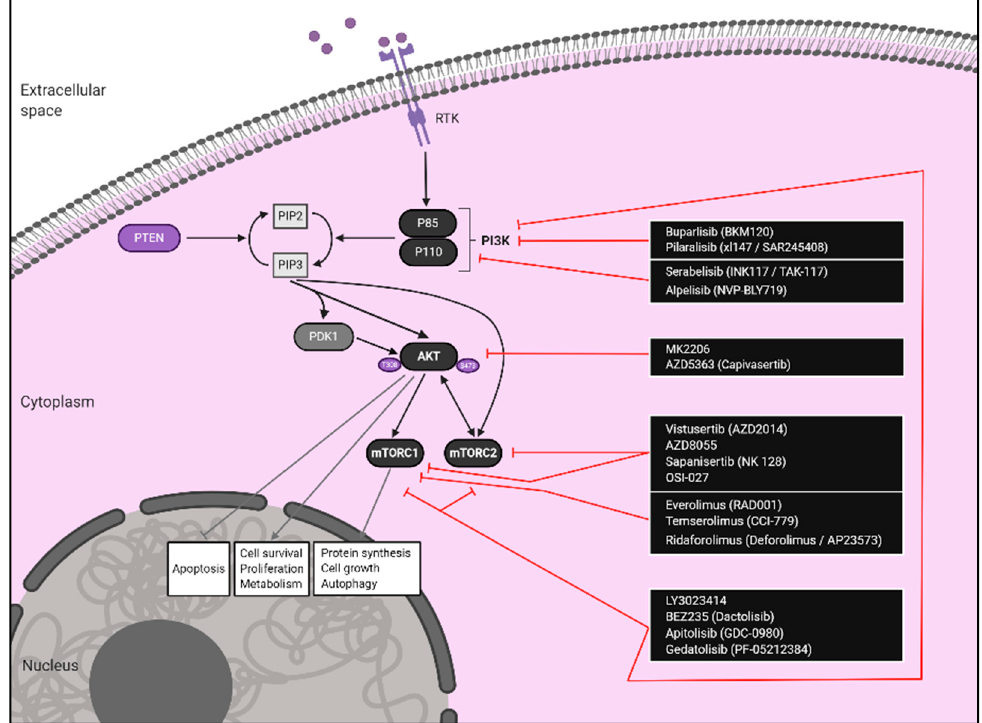
Figure 1. PI3K/AKT/mTOR signalling pathway SMIs for the treatment of endometrial cancer. Current SMIs under clinical investigation and their target molecules are displayed. Abbreviations: RTK, Receptor Tyrosine Kinase.